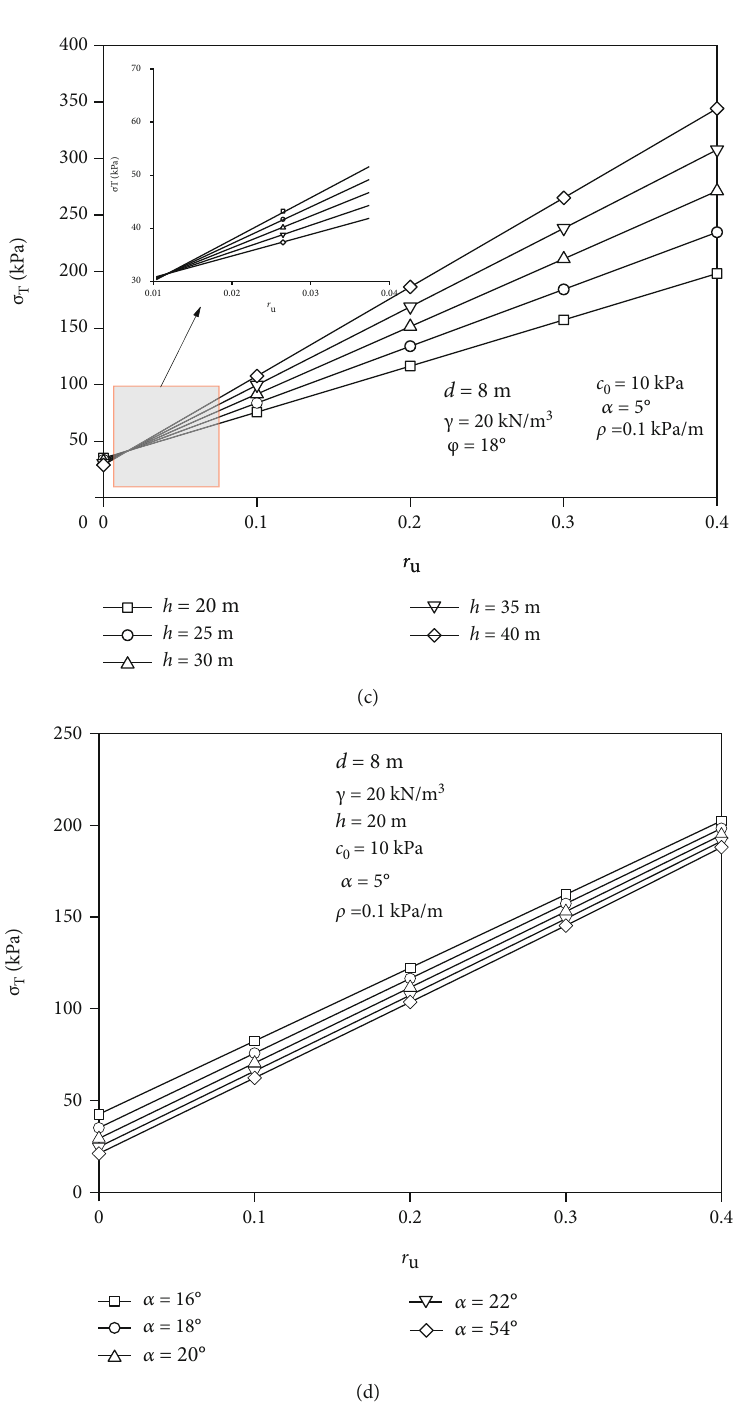
Figure 3: In fl uence of pore water pressure on the supporting pressure: (a) tunnel inclination angle α ; (b) buried depth h ; (c) initial cohesion c 0 ; and (d) internal friction angle φ